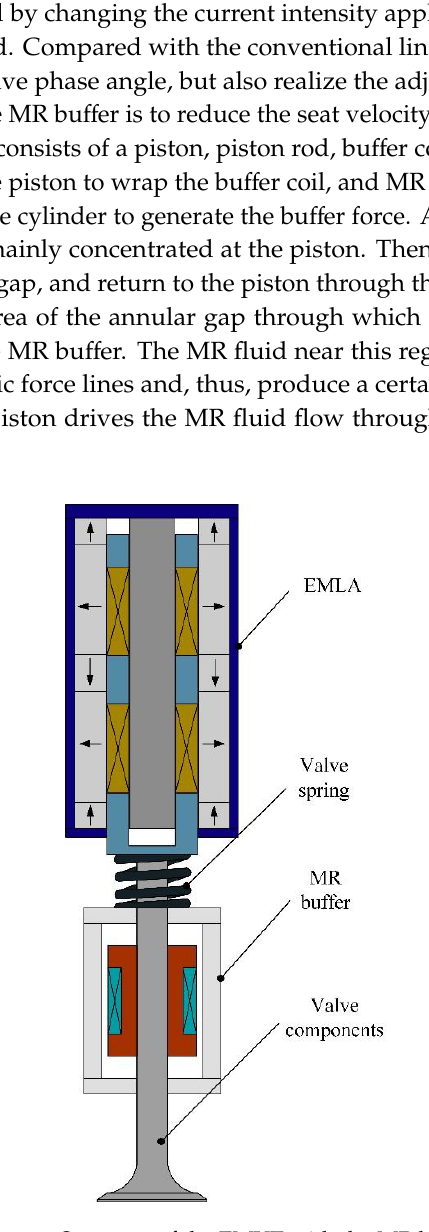
Figure 1. Structure of the EMVT with the MR buffer.